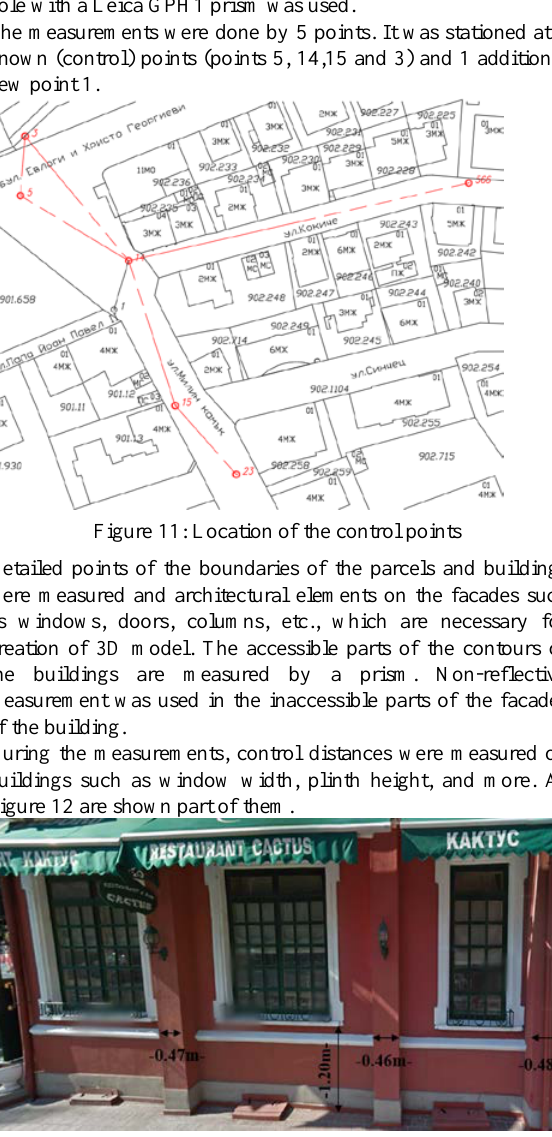
Figure 12: Measured control distances